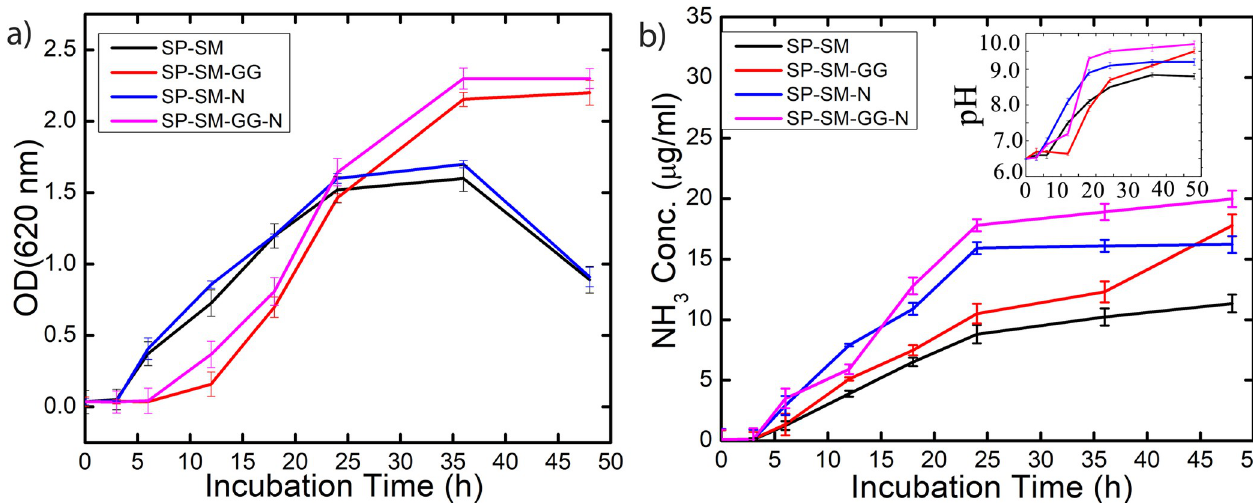
Fig 10. Exploration of microbial physiology under flask condition with and without guar gum additive: (a) microbial growth curve (b) temporal evolution of pH (inset) and ammonium ion concentration in growth medium. Legend shows SM; media without any supplementation, SM-GG; SM media supplemented with 1% guar gum, SM-N; SM media with only 10 mM Nickel chloride supplementation, SM-GG-N; SM media supplemented with 1% guar gum and 10 mM Nickel chloride. S. pasteurii was used as inoculum in all cases. (Error bars represents the standard deviation of the data of three independent experiments).